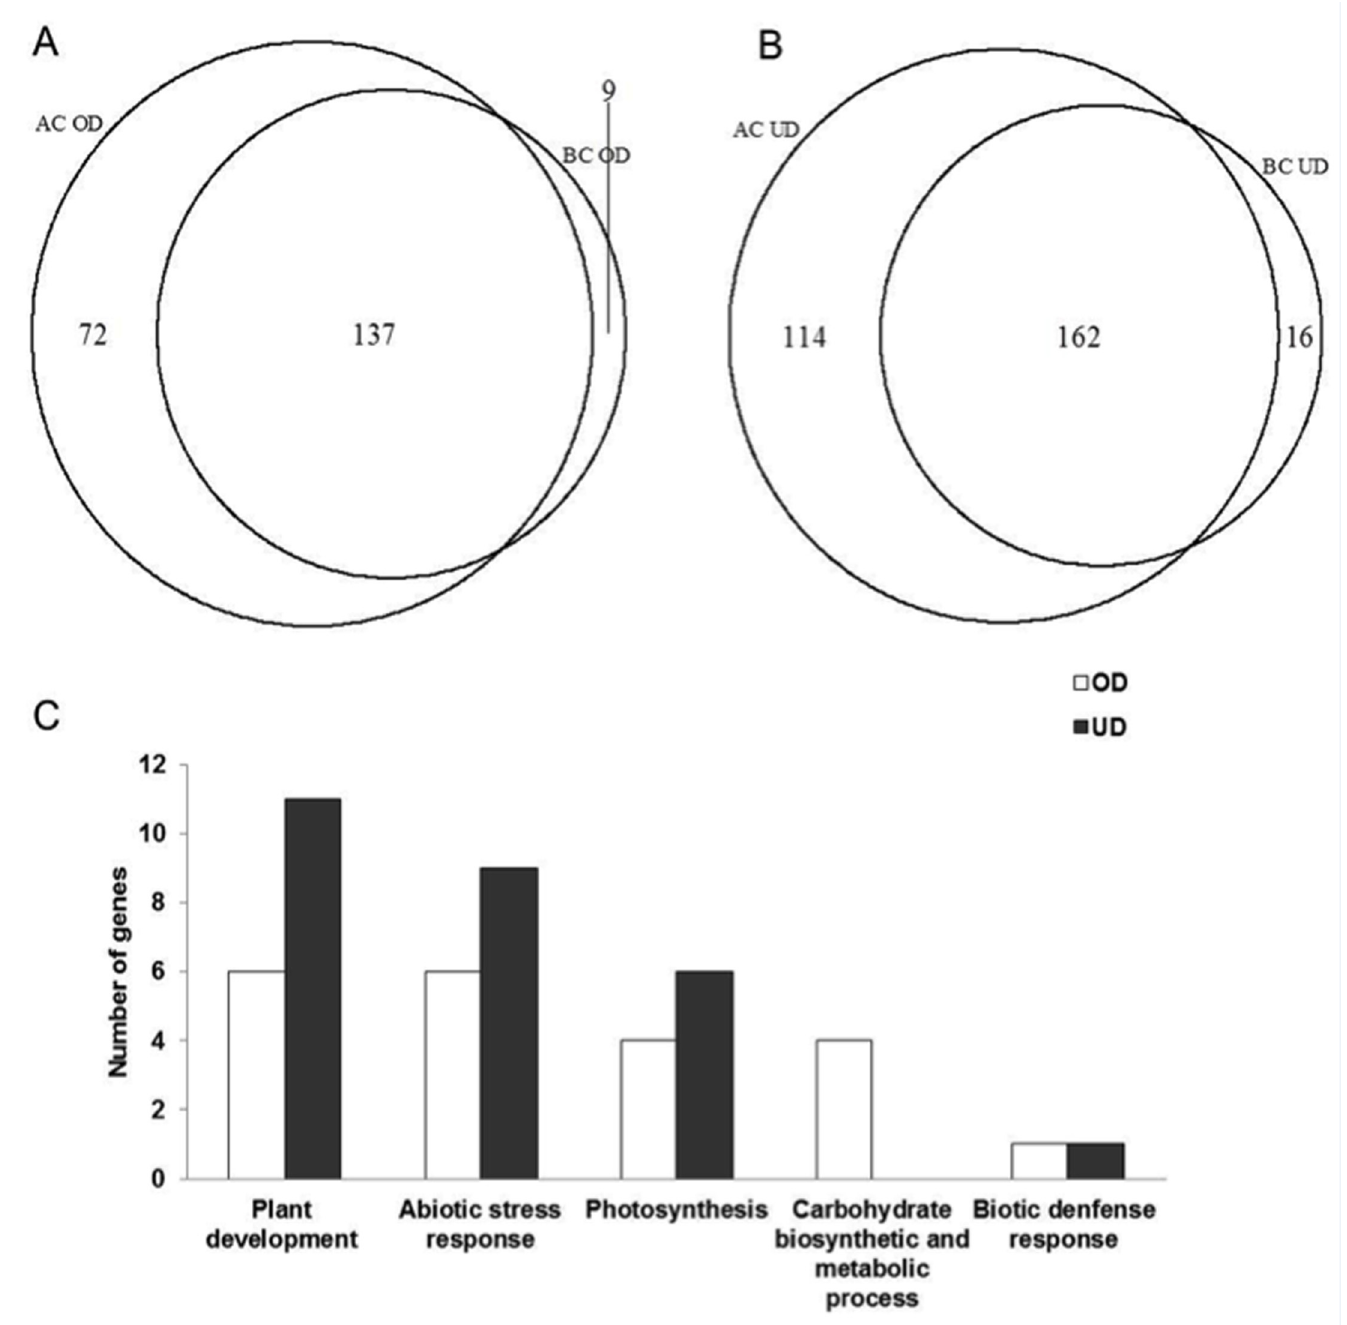
Fig 3. Venn diagram analysis of over-dominance (OD) (A) and under-dominance (UD) (B) genes in Zhengdan958 and Anyu5, and bar plot of GO enrichment analysis of common over-dominance and under-dominance genes between the two hybrids (C). AC and BC denote Zhengdan958 and Anyu5,